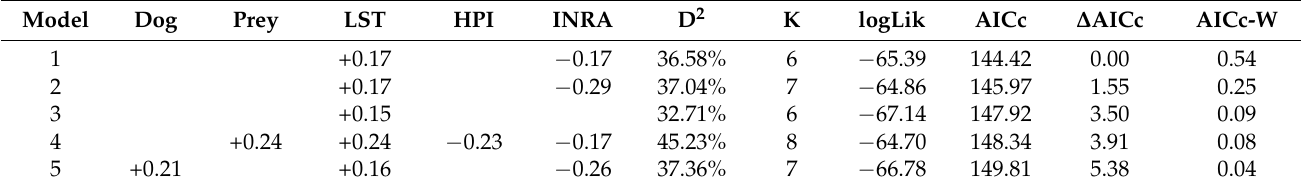
Table 6. Exploratory analysis of potential explanatory variables for observed variability in in the RAI of puma ( Puma concolor ). Only the best five models, as ranked by AICc values, are shown. Positive/negative signs indicate variables and effects considered by each model. Codes are the same as in Table 5.